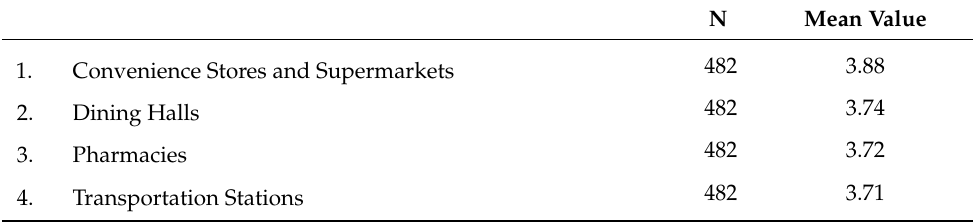
Table 4. The ranking of mean value for elderly satisfaction with individual amenities in old danwei